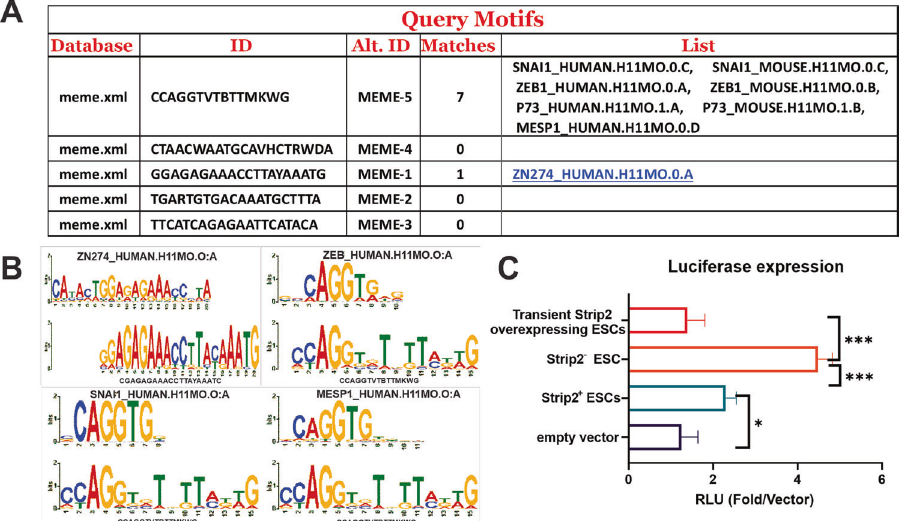
Fig. 2 Top motif hits of DNA motif associated with Strip2 identi fi ed via SeqPos motif tool analysis. A The fi ve best hits are shown. Out of fi ve motifs, motif 1 and 5 have matches to ZNF274 and SNAI1, EXB1 and MESP1. B Motifs signi fi cantly enriched in Strip2 mESCs were identi fi ed by analysis of motif enrichment (AME). C Luciferase expression in Strip2 + -ESCs show that the absence of Strip2 (Strip2 − -ESCs) further stimulates expression, while Transient overexpression of Strip2 reduces expression to baseline levels. Average fold change of relative luciferase units (RLU) vs empty vector ( n = 3, mean ±